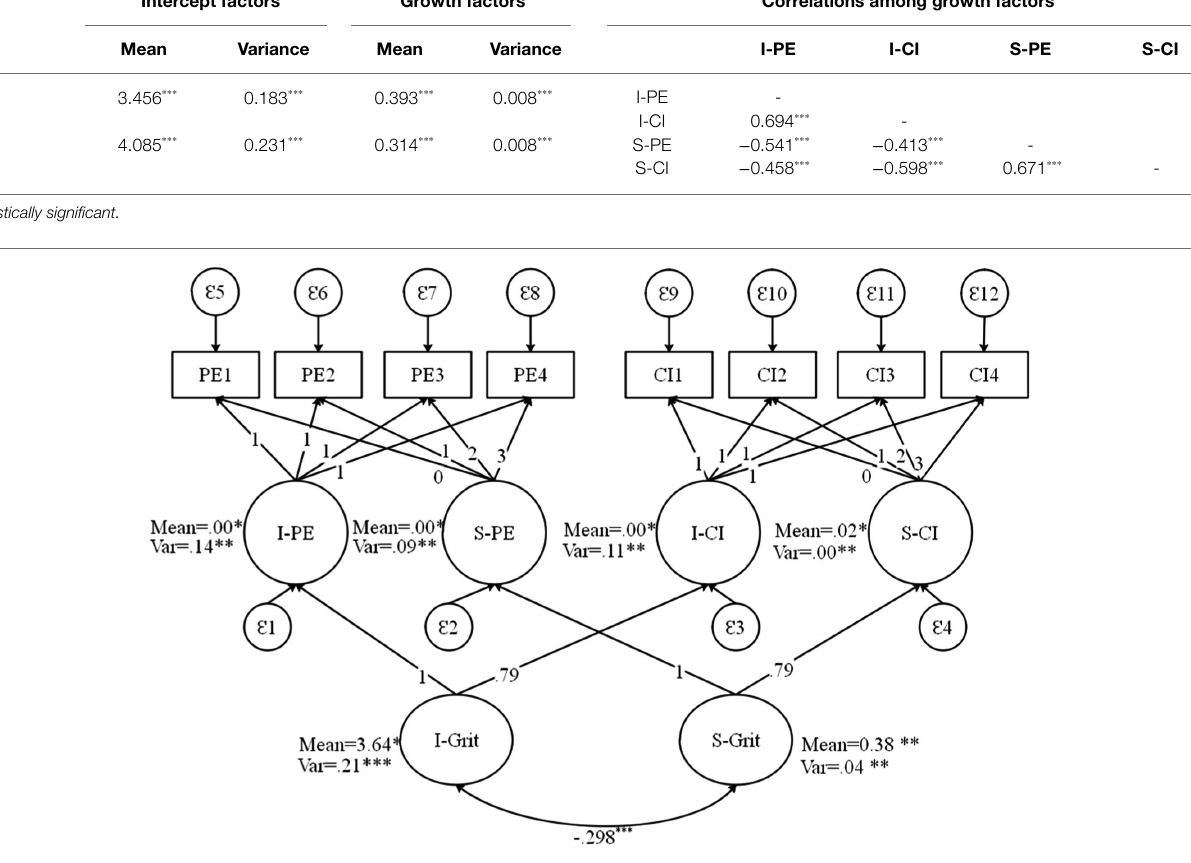
FIGURE 2 | Factor-of-curves model (FCM) of L2 grit. I, intercept; S, slope; PE, perseverance of effort; and CI, consistency of